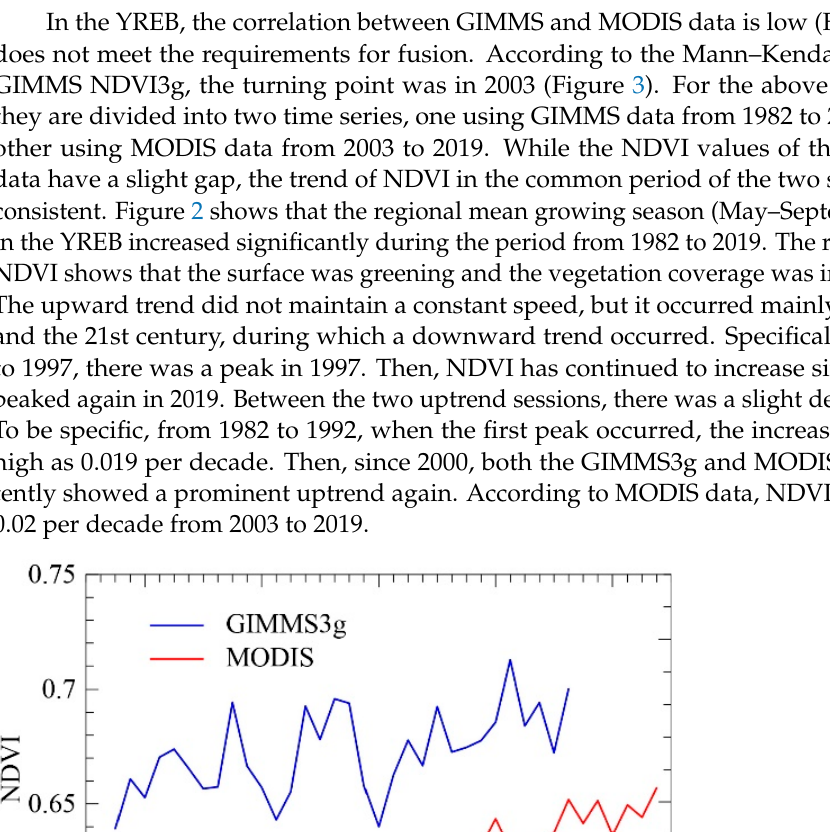
Figure 3. Mann–Kendall test of GIMMS3g NDVI during 1982 to 2013. 3.1.2. Spatial Variations of NDVI Trends during the Warm Season Figure 4 shows the spatial patterns of the NDVI trends for each period. We found that the hotspots of NDVI changes shifted from one period to another. During 1982–2003, the NDVI uptrend existed over approximately 81.7% of the study area. It mainly existed in the north of Jiangsu and Anhui, Hubei, Hunan and the west of Yunnan. In the north of Jiangsu, the NDVI uptrend was the largest, with an increasing rate of up to 0.1 per decade, making it a hotspot of surface greening. This could be explained by the increase of crop yield due to the development of modern agriculture [7]. Meanwhile, the areas where NDVI decreased during this period mainly existed in the Yangtze River Delta urban ag- glomeration, the Wuhan urban agglomeration and the Chengdu-Chongqing urban ag- glomeration, among which the Yangtze River Delta urban agglomeration changed most significantly. The NDVI change rate of the Yangtze River Delta is approximately − 0.07 per decade, which is the much larger than other areas. This result was consistent with the findings of Jiang et al. (2022) [35].